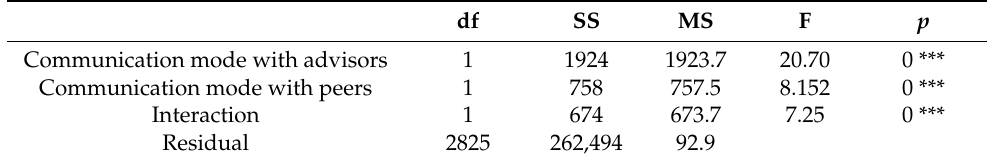
Table 6. Two-way ANOVA results of depression. df SS MS F p Communication mode with advisors 1 2401 2401.4 20.341 0 *** Communication mode with peers 1 836 835.9 7.081 0 *** Interaction 1 766 766.3 6.491 0.01 * Residual 2825 333,507